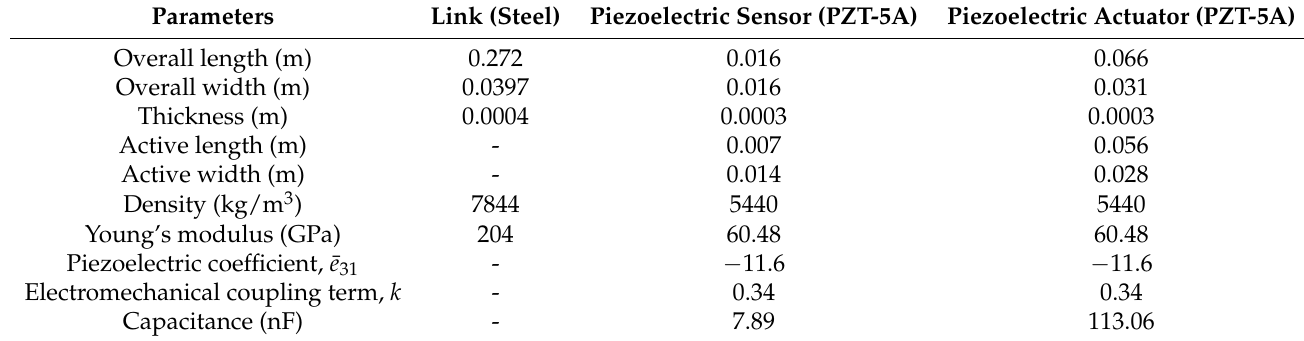
Table 1. Geometric, mechanical and electric properties of link B and piezoelectric patches [1].